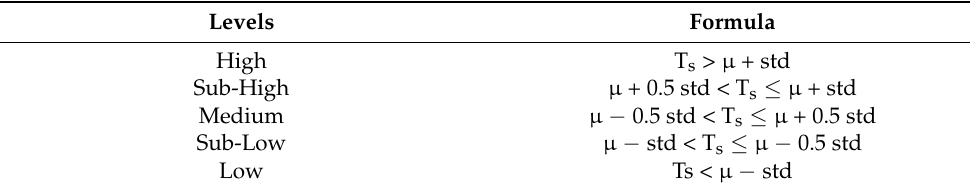
Table 2. The classification of the surface temperature and the used formula (T s is the zone of different temperature levels, µ is the average temperature of the study area, and std is the standard deviation of the LST in the study